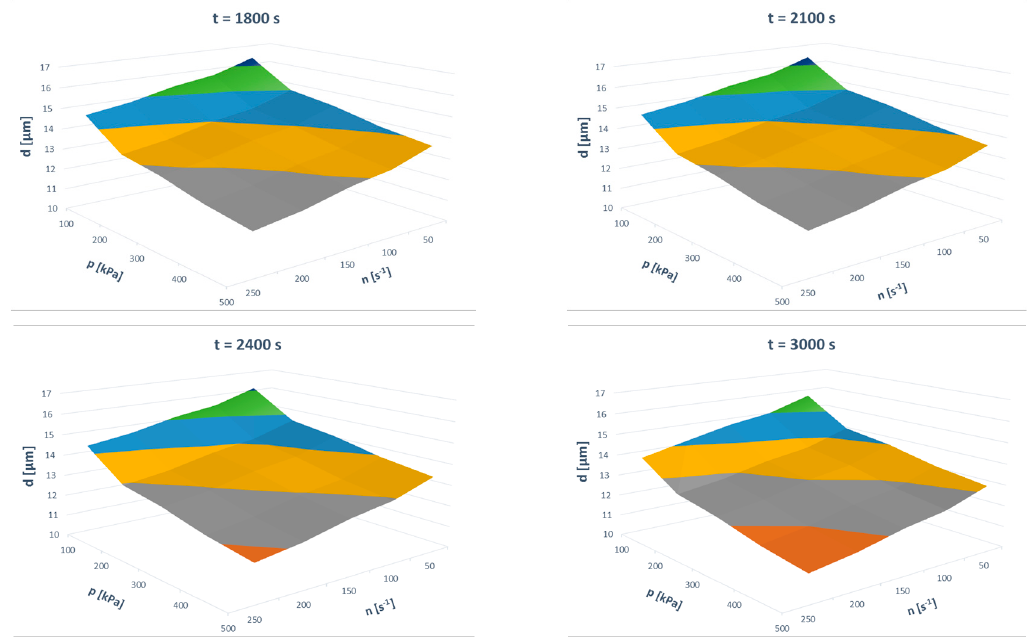
Figure 12. Effects of the input parameters on the mean Sauter diameter of the grinding product.